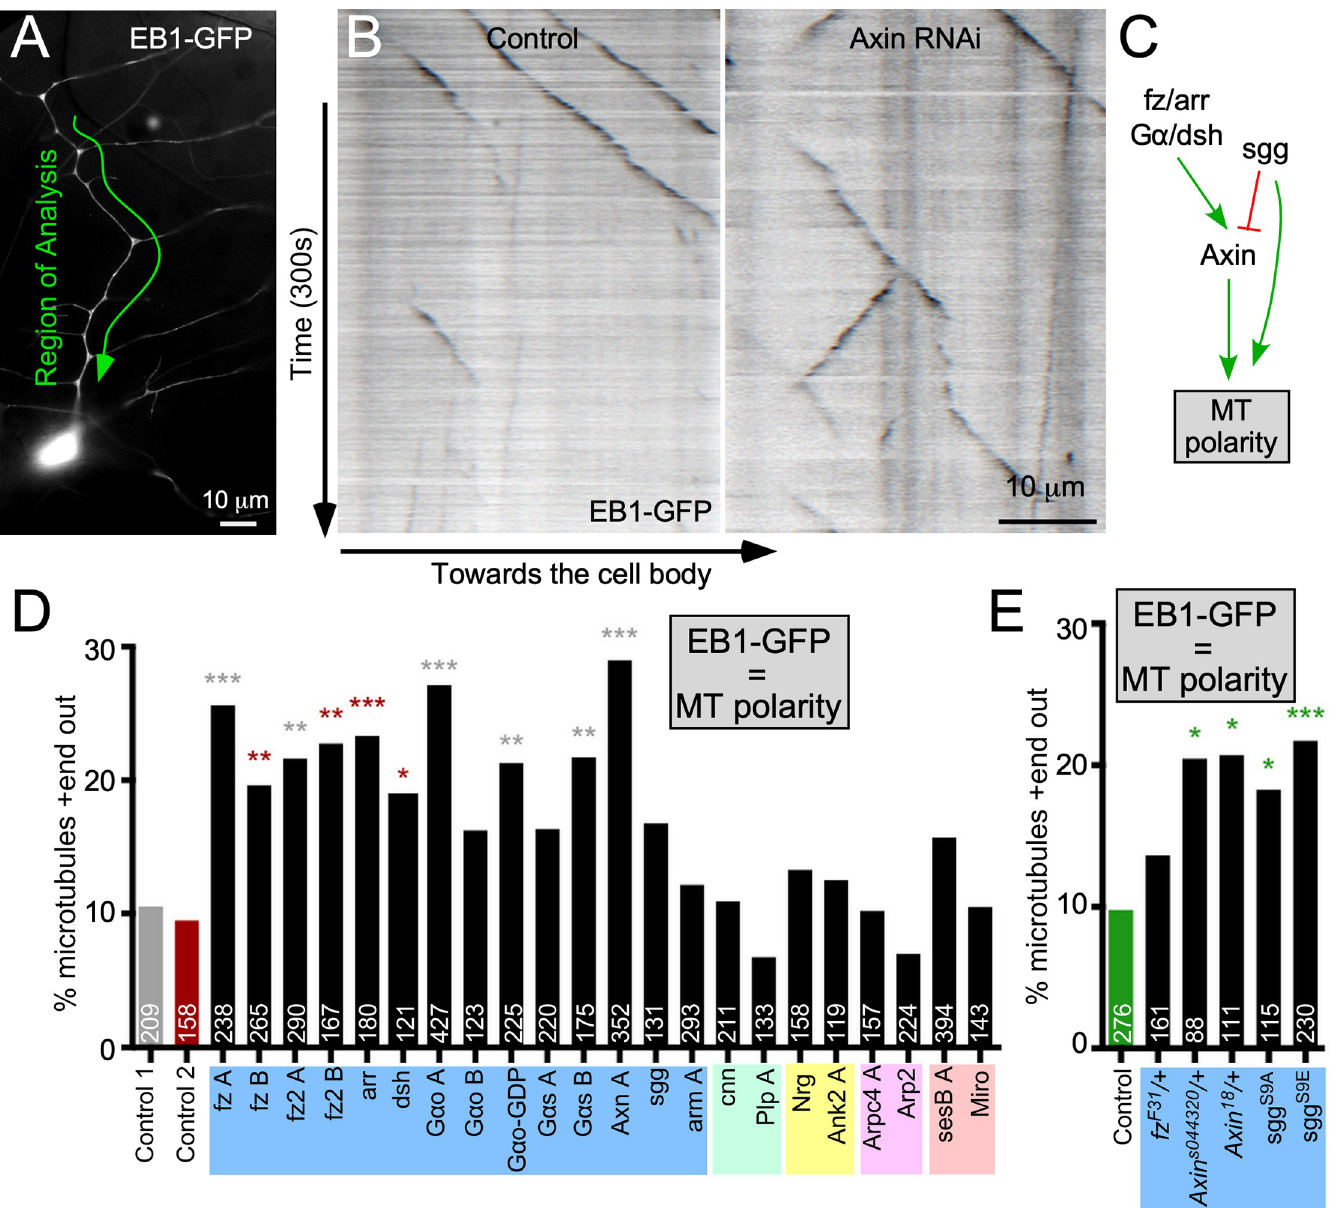
Fig 3. Wnt signaling proteins are required for minus-end-out microtubule polarity in dendrites. (A) An overview of the ddaE neuron dendrite arbor is shown. The main trunk of the ddaE neuron used for EB1-GFP movies is highlighted. (B) The 300-second movies of EB1-GFP were acquired in the ddaE dorsal dendrites, and kymographs were generated in Fiji. Cells also expressed either UAS-Rtnl2 RNAi (control 1) (VDRC 33320) (left) or UAS-Axin RNAi (VDRC 7748) (right). (C) A summary of data in earlier figures as well as some previous data [27] is shown. (D) Quantification of EB1-GFP comet direction in the main trunk of the ddaE dendrite in animals expressing hairpin RNAi’s. The percentage of microtubules oriented plus-end-out is plotted as a summed value across all cells for each genotype. The numbers on each bar are total EB1-GFP comets counted, and at least 15 cells were analyzed for each genotype, with one cell per animal. Data in panel D were collected by two different individuals; the gray bar shows control data from one individual, and the red bar is from the other individual. Experimental genotypes analyzed by an individual were compared with their own control data, and significance stars are color-coded to indicate the comparisons. (E) Quantification of microtubule polarity from mutant and dominant-negative strains compared with control data without an RNAi transgene. A logistic regression was used to determine significance. � p < 0.05, �� p < 0.01, ��� p < 0.001. Refer to S1 Table for all genotypes and S1 Data for data used to generate graphs in (D) and (E). Ank2, Ankyrin 2; Arp2, actin related protein 2; Arpc4; actin related protein c4; arr, arrow; Axn, Axin; dda, dorsal dendritic arborization; EB1, end-binding protein 1; G α , G protein alpha subunit; GDP, guanosine diphosphate; GFP, green fluorescent protein; Miro, mitochondrial rho; MT, microtubule; Nrg, Neuroglian; Plp, Pericentrin-like protein; RNAi, RNA interference; Rtnl2, reticulon 2; sgg, shaggy; UAS, upstream activating sequence; VDRC, Vienna Drosophila Resource Center.